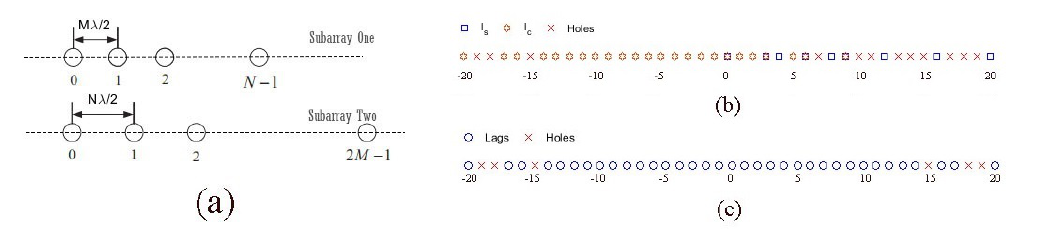
Figure 1. A coprime array configuration. ( a ) ULAs with sensor spacings related to a coprime array. ( b ) The sets L s and L c with M = 3 and N = 4. ( c ) The lags positions in full set L p with M = 3 and N =